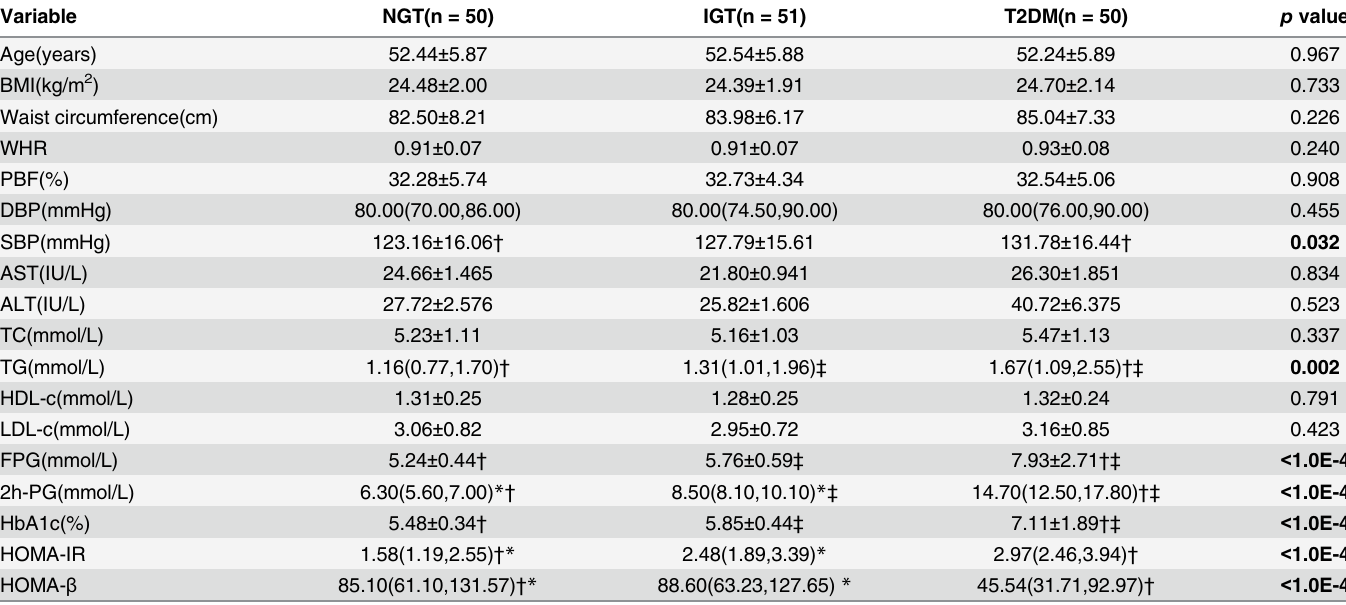
Table 1. Demographic and biochemical characteristics of the study